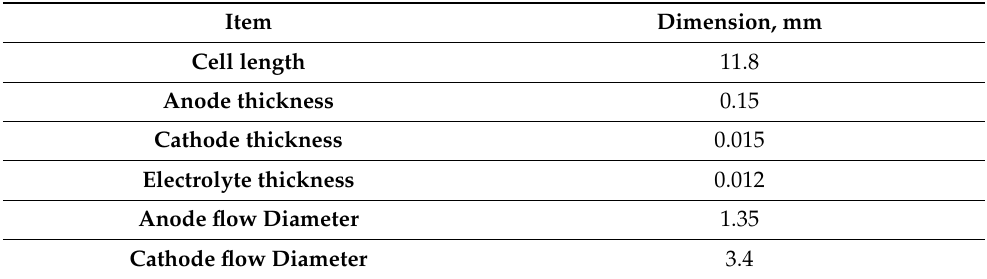
Table 1. Cell component dimensions.